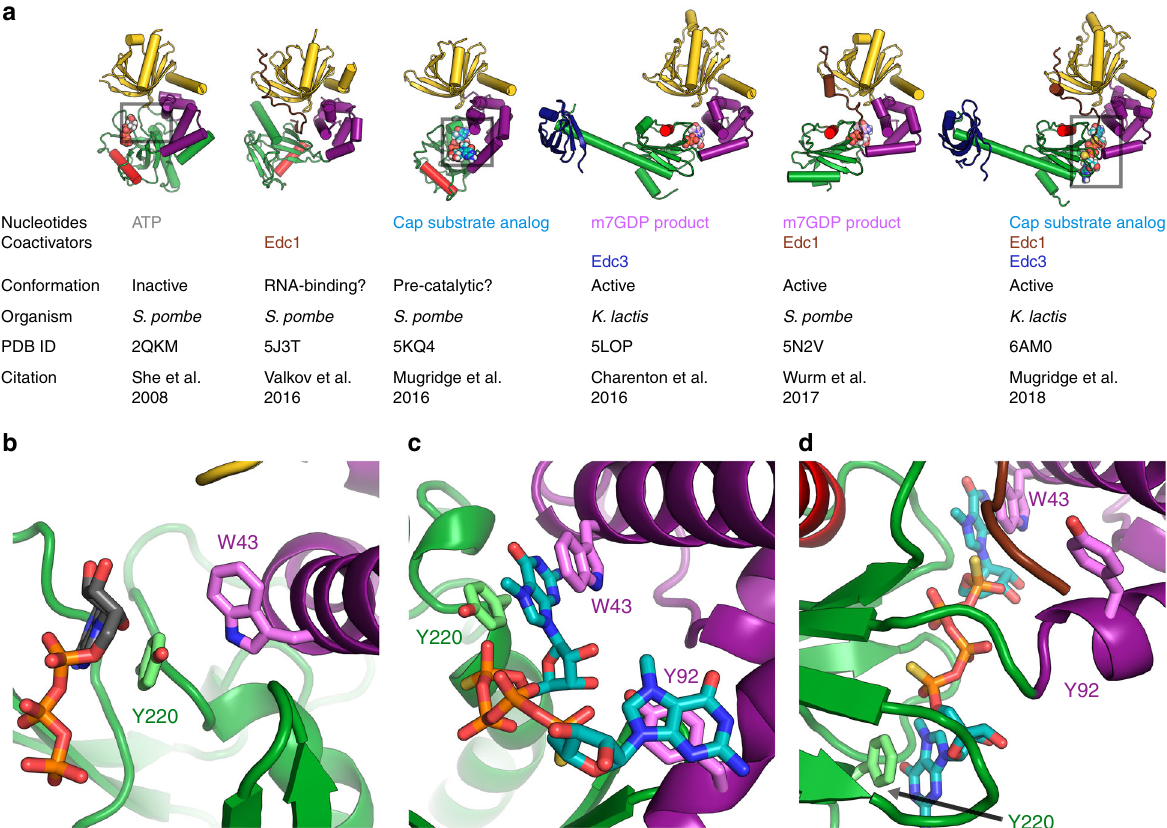
Fig. 5 Summary of recent Dcp1 – Dcp2 structures and interactions between important aromatic cap-binding residues in different conformations. a Gallery showing the different overall conformations of recent Dcp1 – Dcp2 structures. Text lists bound nucleotides, coactivators, and proposed description of the Dcp2 conformation. Dcp1 is yellow, Dcp2 NRD is purple, Dcp2 CD is green with the catalytic Nudix helix colored red, Edc1 is brown, Edc3 is dark blue,